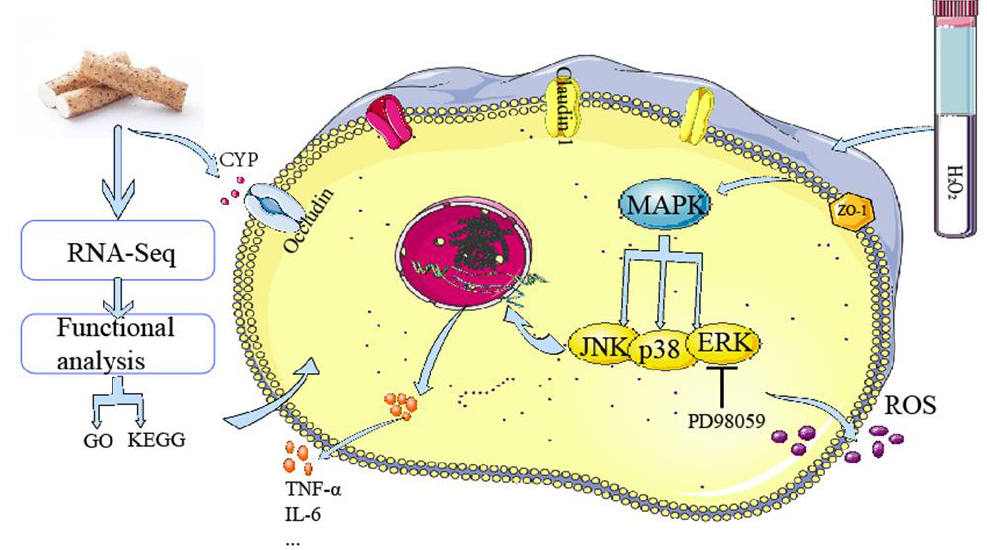
Figure 7. Schematic of mechanism in CYP on H 2 O 2 -induced oxidative damage in IEC-6 cell.